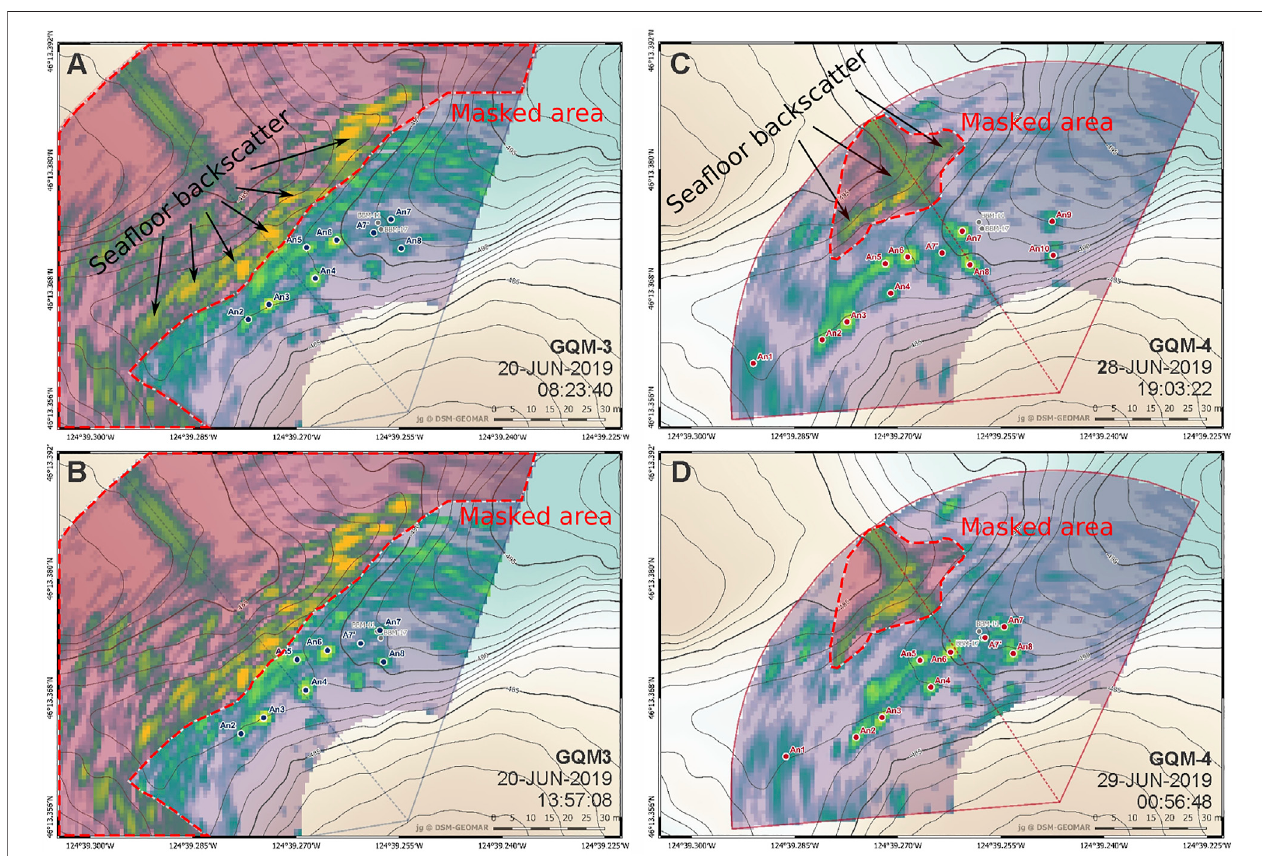
FIGURE 6 | Bathymetric maps of the study area including GQM echogram-fan at different times for the two deplyments. The maps include the average position at different times of the tracked anomalies related to gas seepage, the position of the Bubble-Box lander from the different BBM deployments, the upper view of the areal coverageofeachGQMdeployment,andtheeliminatedmaskedregionsforcalculatingtheOVA-maskedamplitudetime-series.Additionally, (A,B) echogramsrelatedto times when anomalies were at their maximum displacement to the east and west, respectively, are shown for deployments GQM-3 (A,B) and GQM-4 (C,D) . The image also indicates the acoustic anomalies related to sea fl